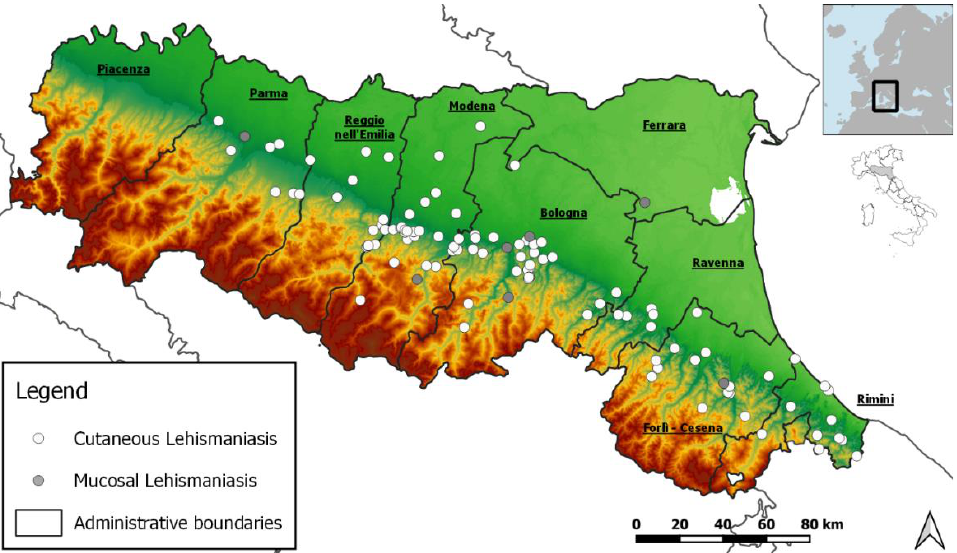
Figure 1. Geographic distribution of autochthonous cases of tegumentary leishmaniasis (n = 113), Emilia-Romagna region, northeastern Italy, 2017–2020.